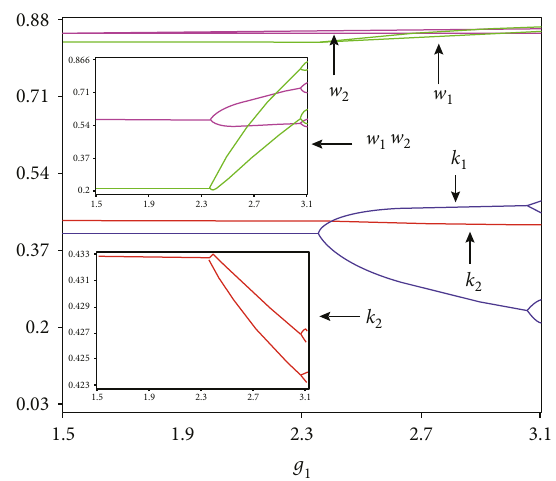
Figure 6: Bifurcation diagram of k